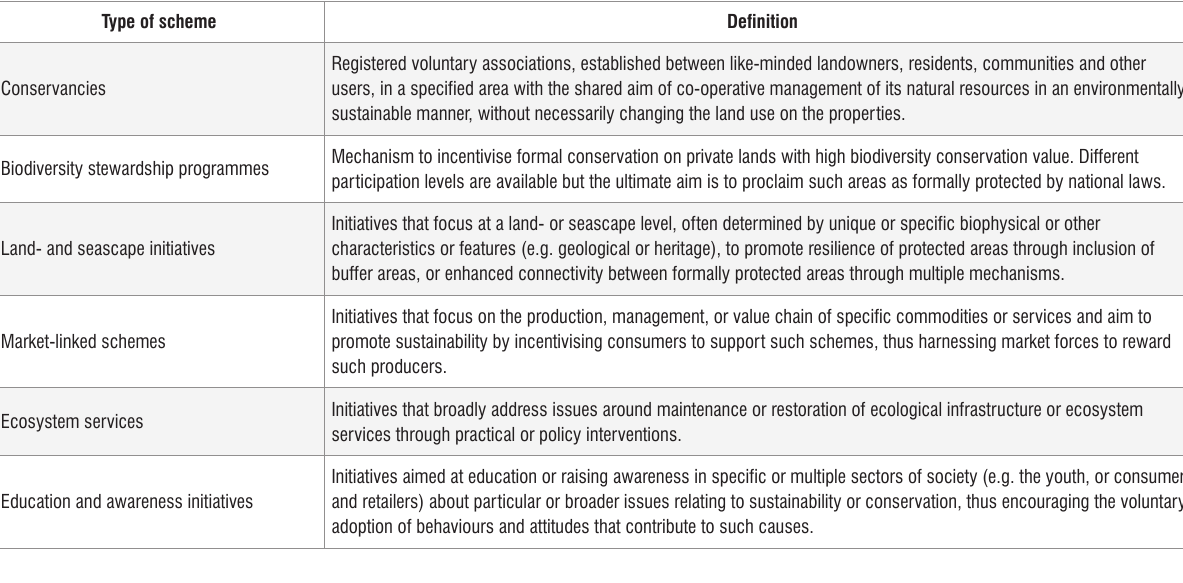
Definitions of main types of conservation and sustainability stewardship schemes identified in South Africa Type of scheme